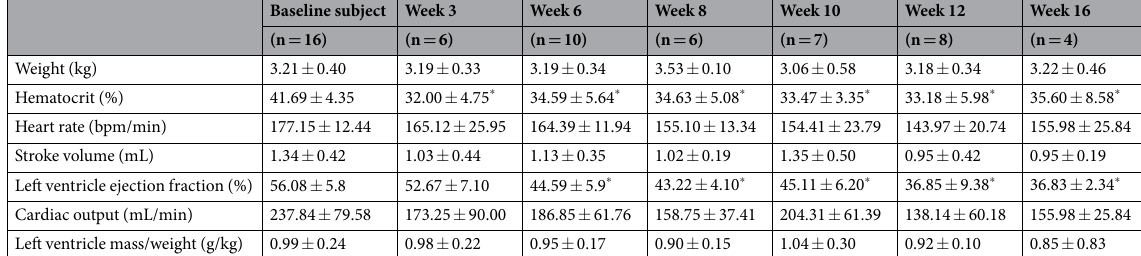
Table 1. Physiological and functional data of all subjects. * Indicated p < 0.05. All data are expressed as mean ± SD.